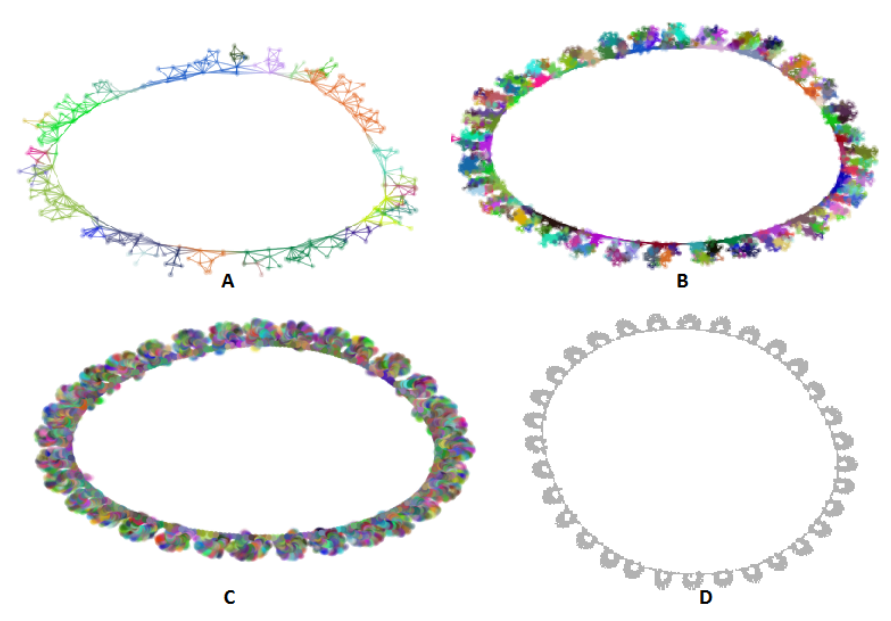
Figure 6. The finan512 layout results. ( A – C ) are three levels of coarsened graphs generated by our algorithm (graph nodes colored by cluster membership); ( D ) is the result from FM 3 implemented by ODGF [40].